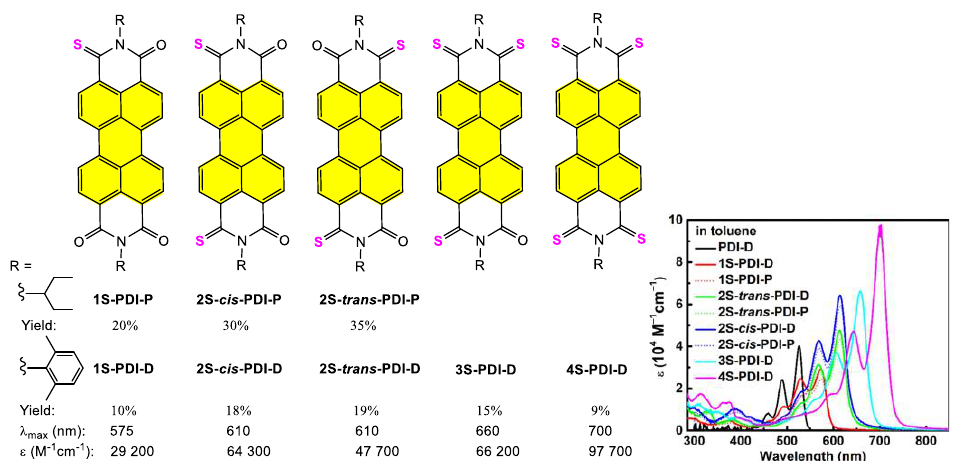
Figure 5. Structures of thiono-PDIs; corresponding UV-Visible spectra. Reprinted with permission from reference [100]. Copyright 2022 American Chemical